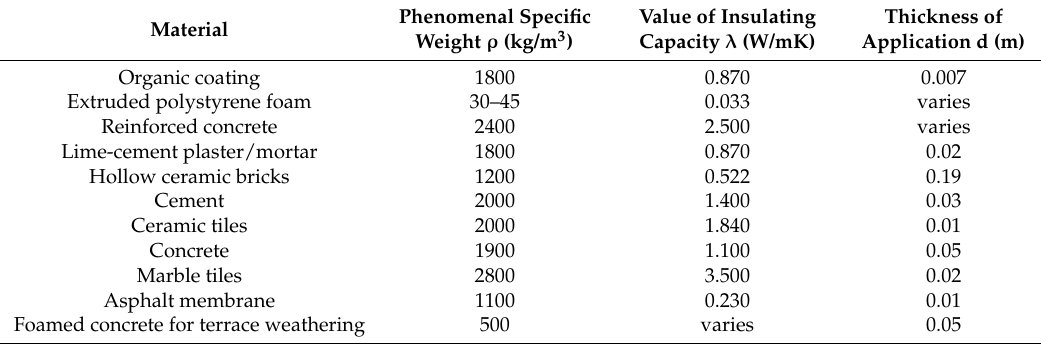
Table A2. Thermal/physical characteristics of building materials used on the reference building [14].